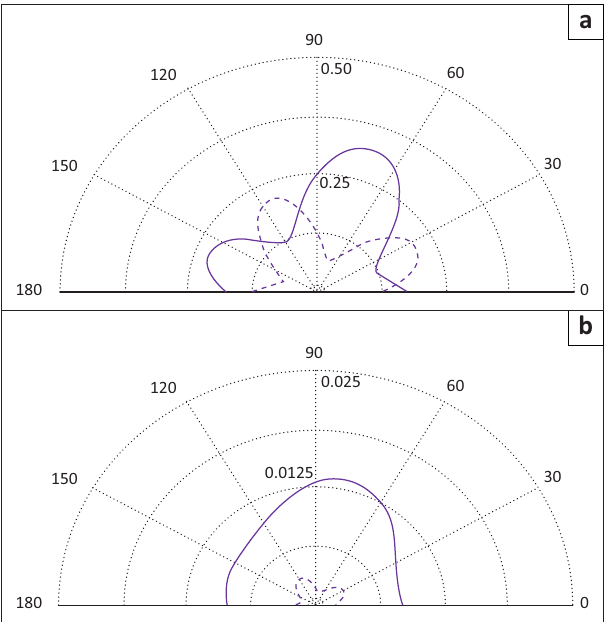
FIGURE 4: Polar profiles of variation in central corneal power of (a) a keratoconic eye and (b) a control eye. The solid curve is curvital and the dash is torsional. The radial scale and outer circle (in dots) are set at 0.5 D 2 and 0.025 D 2 for (a) and (b), respectively. For the keratoconic eye, the meridian of greatest curvital variance is near 70° and torsional variance is maximal near 115°, whereas the control eye displays maximum curvital variation near 80° and maximum torsional variation near 120°. The variances for the control eye are much smaller than that of the keratoconic